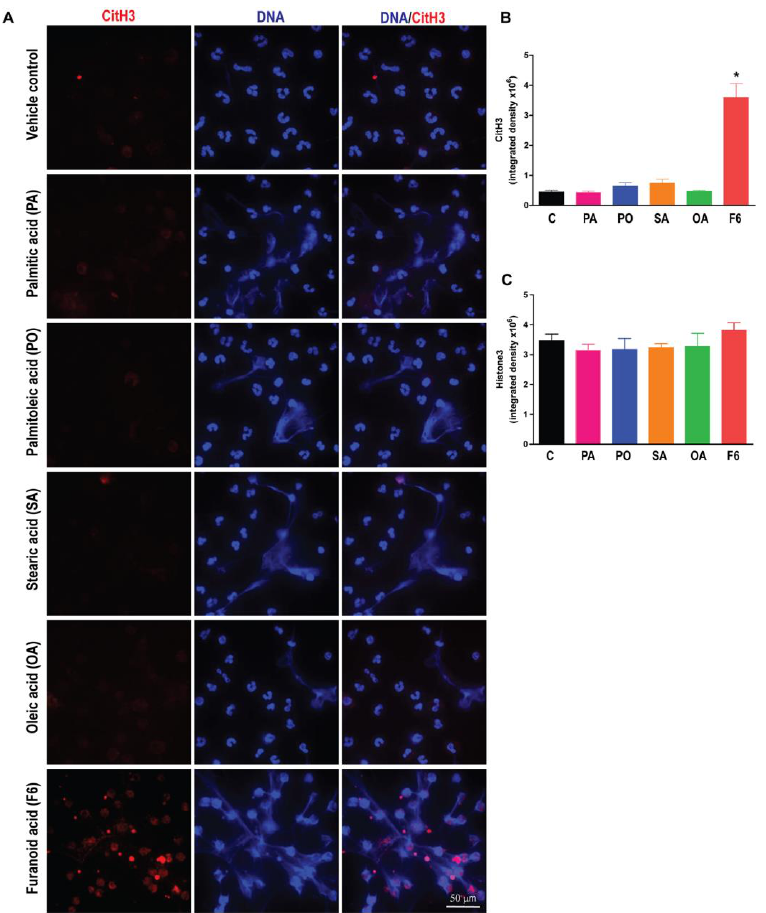
Figure 5. F6 induces histone H3 citrullination (CitH3) during NETosis. ( A ) Neutrophils were incubated either with ethanol ( − ve control), A23187 (+ve control), 5 µ g/0.1 mL of PA, PO, SA, OA, or F6 for 120 min followed by the fixation and immunostaining of the CitH3. Cells were stained for CitH3 (red) and DNA (DAPI; blue). Confocal fluorescence images show the substantial CitH3 immunostaining in neutrophils treated with F6, while the control and PA-, PO-, SA-, or OA-treated neutrophils lack CitH3 immunostaining (scale bar, 50 µ m; images are representative of three independent experiments). See the Supplementary Figure S4 for the CitH3 in the positive control A23187-treated neutrophils; ( B ) CitH3 was quantified from the images using Image J ( n = 3; * p < 0.05 compared to control; One-way ANOVA followed by Dunnett’s post-test); ( C ) Histone H3 was quantified from the images using Image J ( n = 3; One-way ANOVA; the differences in these controls are not significantly different; images not